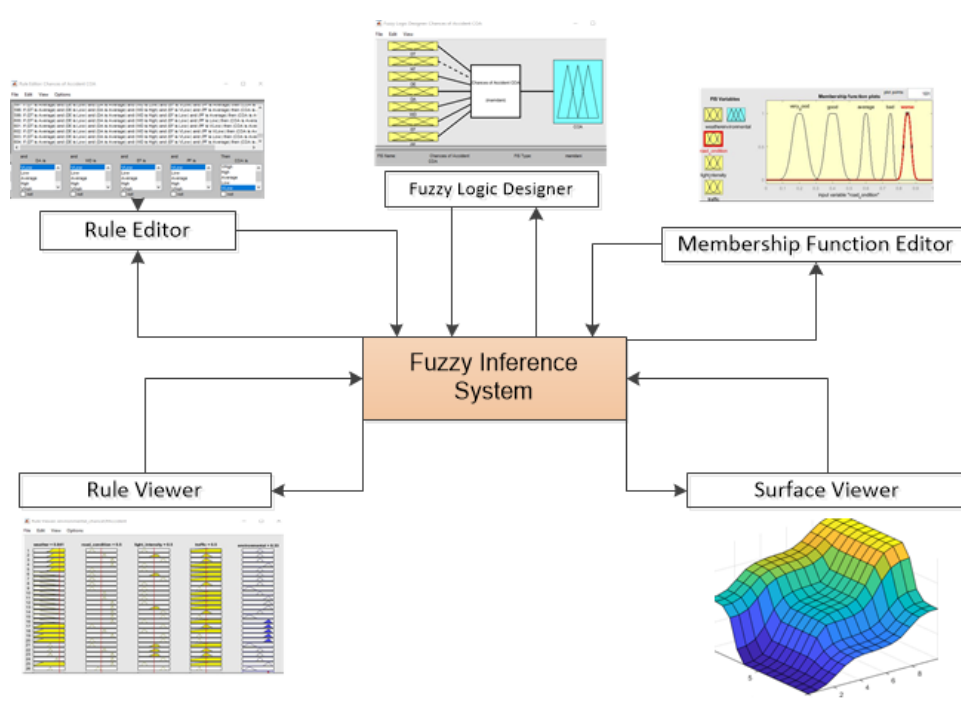
Figure 4. Fuzzy Inference System to apply membership functions.